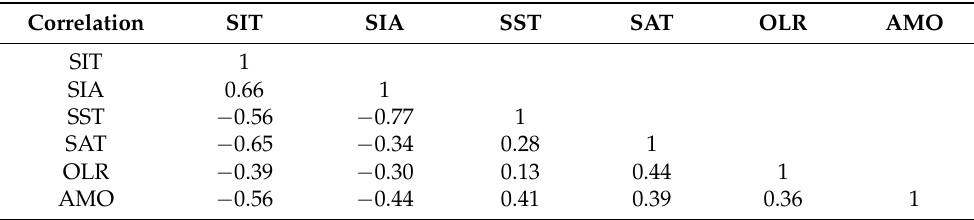
Table 5. Correlation matrix of the monthly anomalies (1979–2020) of SIT, SIA and atmospheric, oceanic parameters for the Pacific sector (the numbers are statistically significant at a confidence level of 99%).